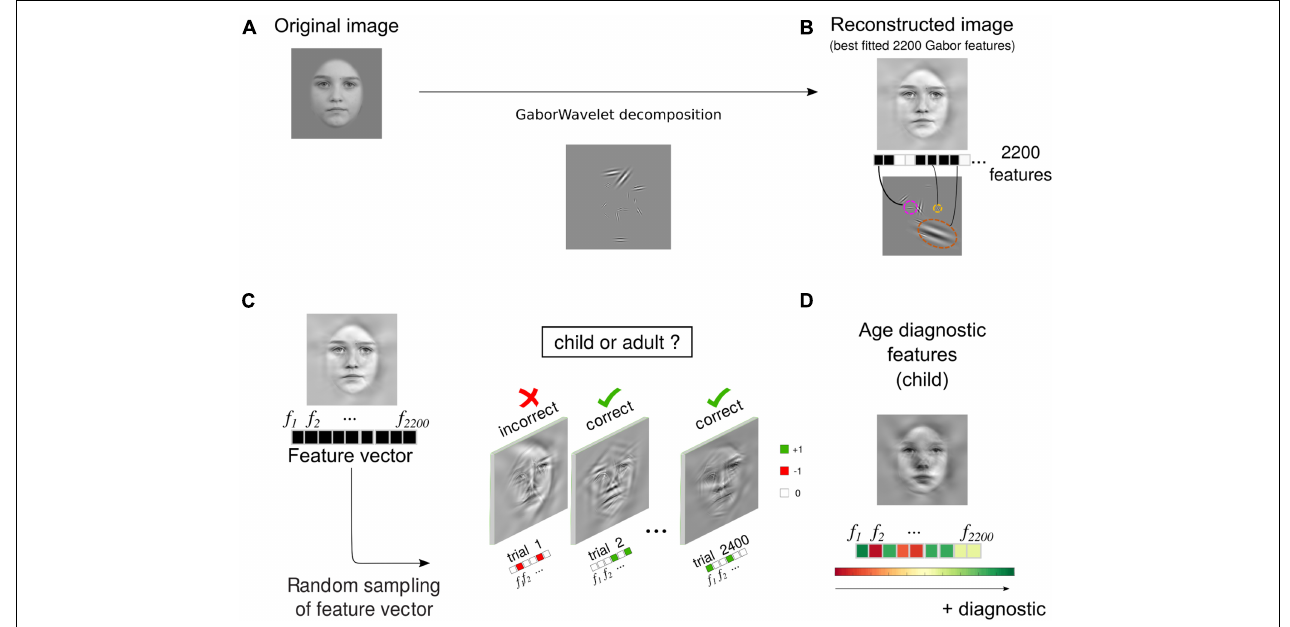
FIGURE 1 | Image feature decomposition and reverse-correlation procedure. A reconstructed image ( B , lower image) was created using a subset of 2200 Gabors wavelets varying in spatial-frequency (from 2.4 to 87 cpi), orientation (10 ◦ –180 ◦ ), x – y coordinates, and size. These 2200 wavelets, the most correlated with the original image (A) , are referred to as Gabor features (see also Alink and Charest, 2020 for further details). (C) At any given trial, the stimulus was created by randomly sampling the 2200 Gabor features to reveal parts of the reconstructed image. Participants were asked to indicate whether the resulting sampled face was a child or an adult. Each participant was submitted to 2.4k trials, for a grand total of > 38k trials. (D) We obtained the diagnostic features by weighing and summing the randomly sampled feature vectors across trials with z -scored behavioural accuracies. (Image source: Langner et al.,